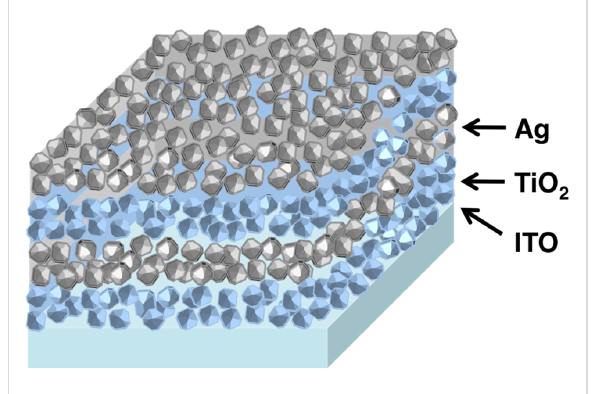
Figure 1: Scheme of the one-dimensional photonic crystal made of layers of silver nanoparticles and titanium dioxide nanoparticles. The actual photonic crystal fabricated in this work is composed of five silver/titanium dioxide